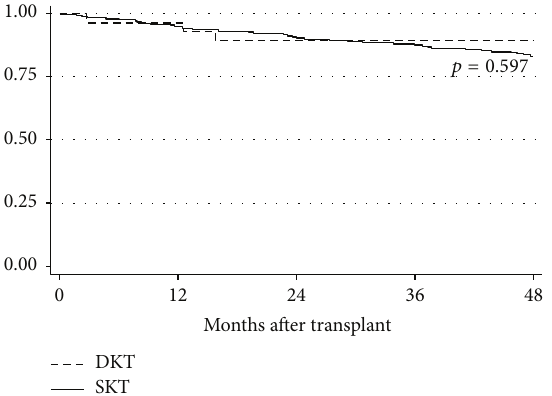
Figure 4: Actuarial graft survival of dual kidney transplant (DKT) and single-kidney transplant (SKT)